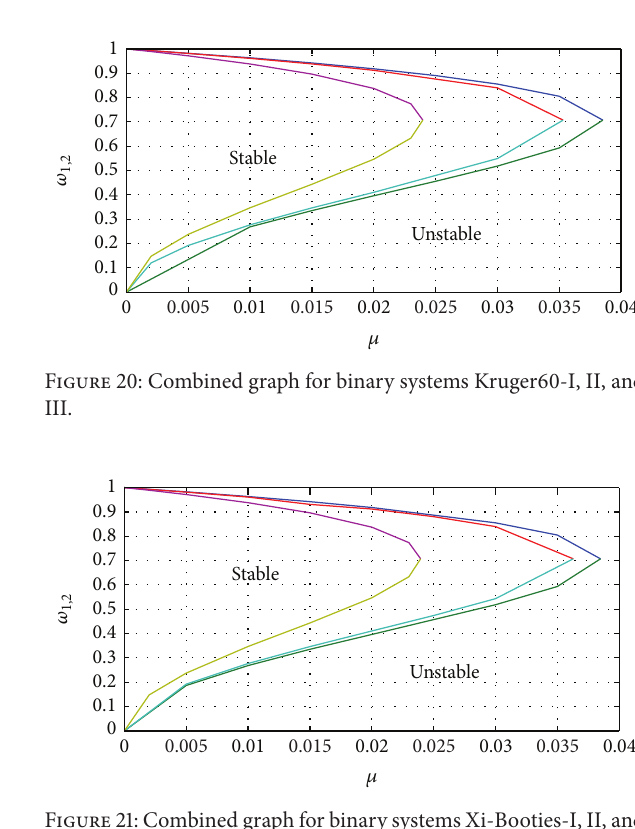
Figure 19: Combined graph for binary systems Alpha Cen AB-I, II, and III.